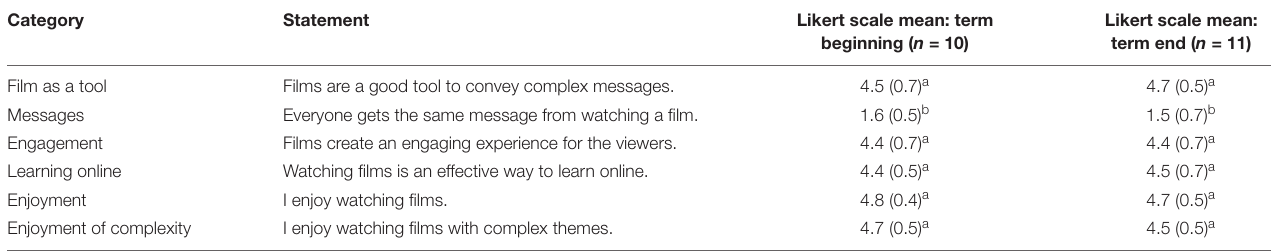
TABLE 2 | Opinions of films as an engaging and enjoyable tool for conveying complex messages in online learning, students were asked to rate each statement on a scale of 1 (strongly disagree) to 5 (strongly agree).